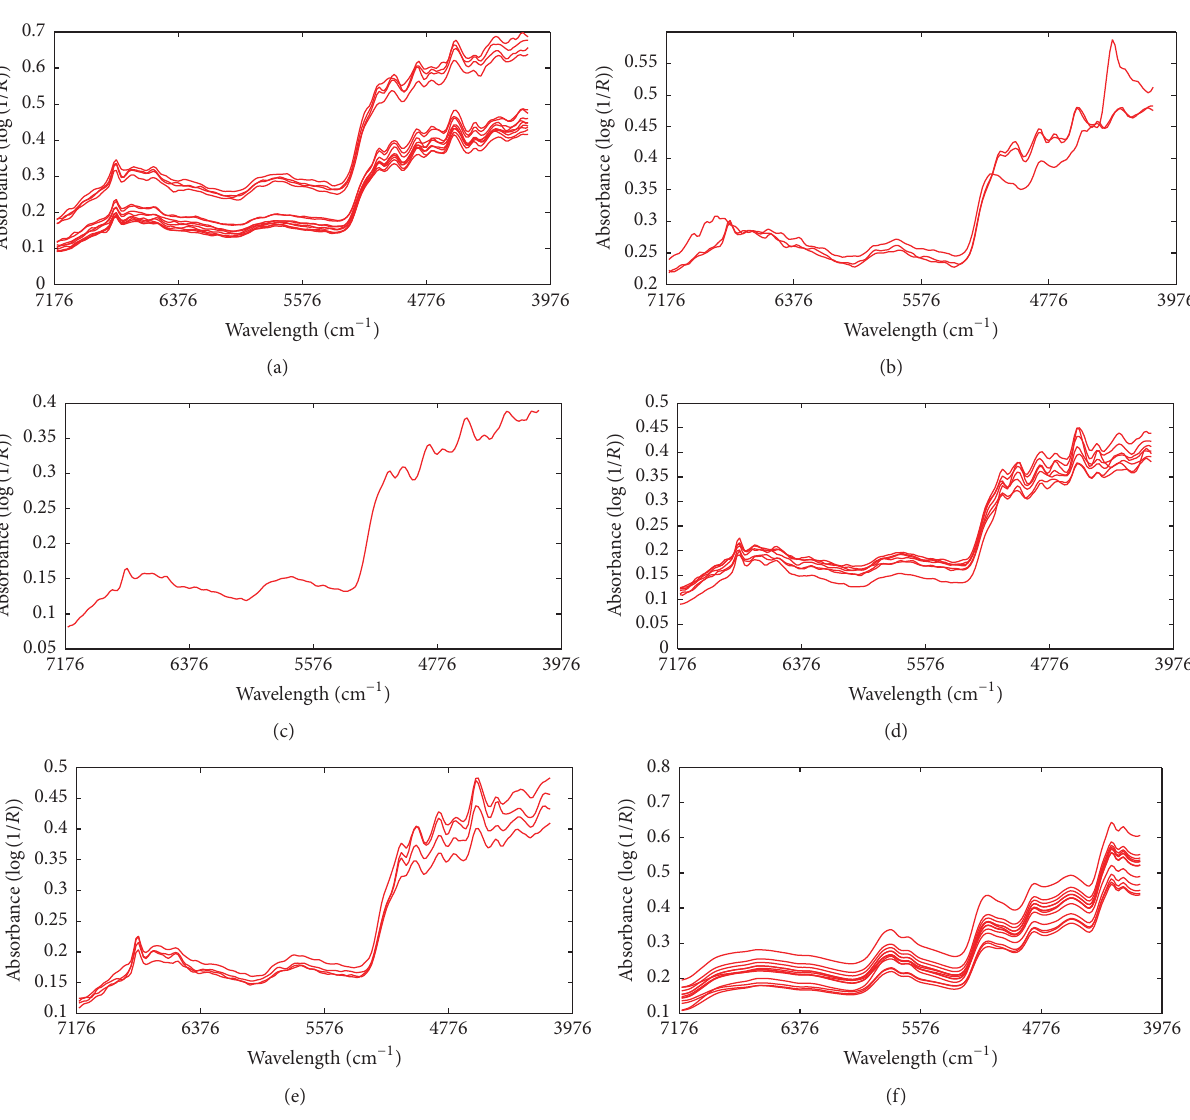
Figure 7: The spectra out of both GH and 𝐶 𝑗 liminal values. (a), (b), and (c) represent 1000, 500, and 100mg kg −1 of melamine images, (d) and (e) represent two 50 mg kg −1 of melamine images, and (f) represents Soy 6